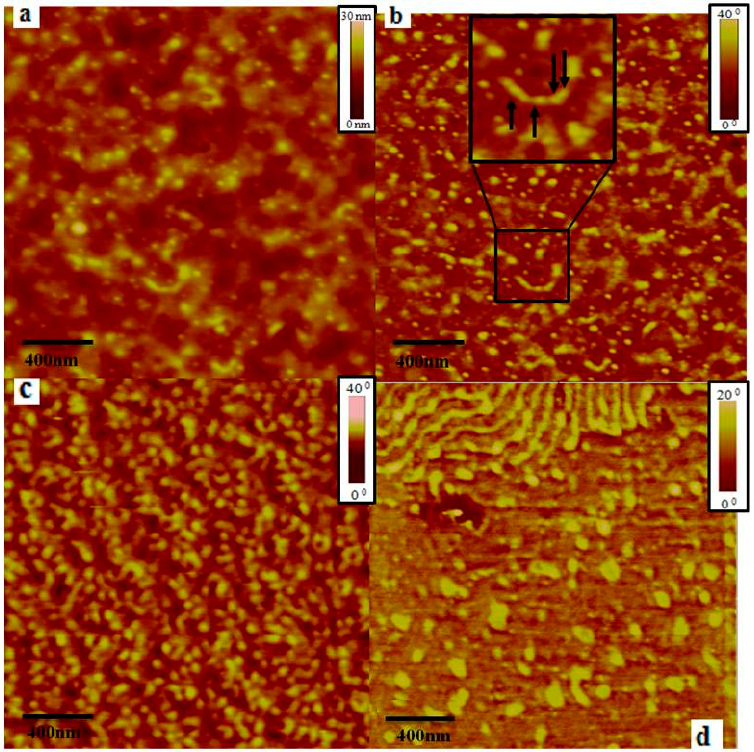
Figure 1. Height and phase ( a , b ) images after solvent vapor annealing (SVA) treatment for 90 min. of PB 40 - b -PS 40 _PS-Fe 2 O 3 composite thin film. In Figure 1b, an enlarged view is given with arrows indicating the position of the NPs. Phase image ( c ) correspond to SVA treated film for 6 h. Phase image ( d ) depicts the morphology for 24 h SVA treatment. The NPs loading is kept constant at 10% wt. All samples correspond to almost identical film thickness.